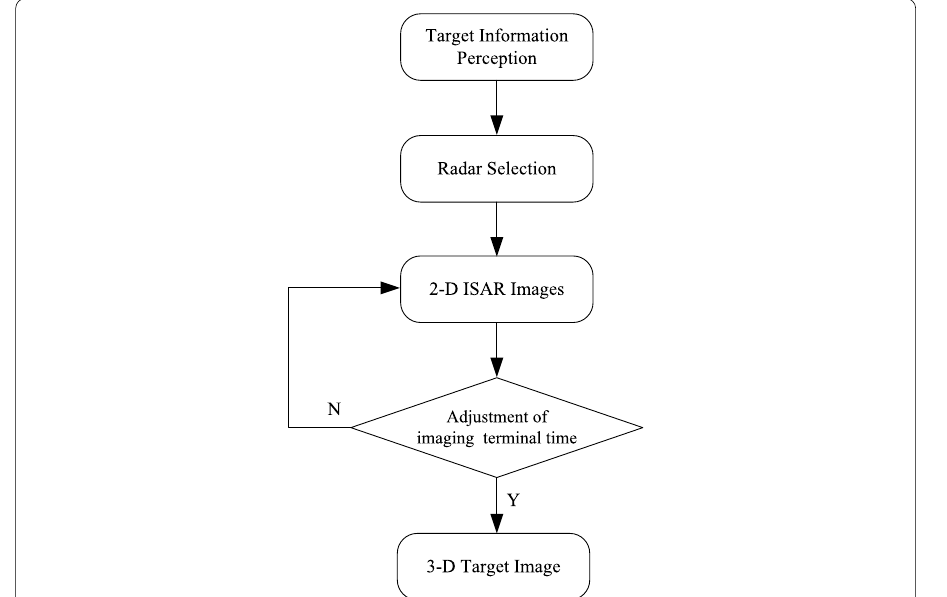
Fig. 6 The framework of adaptive task schedule